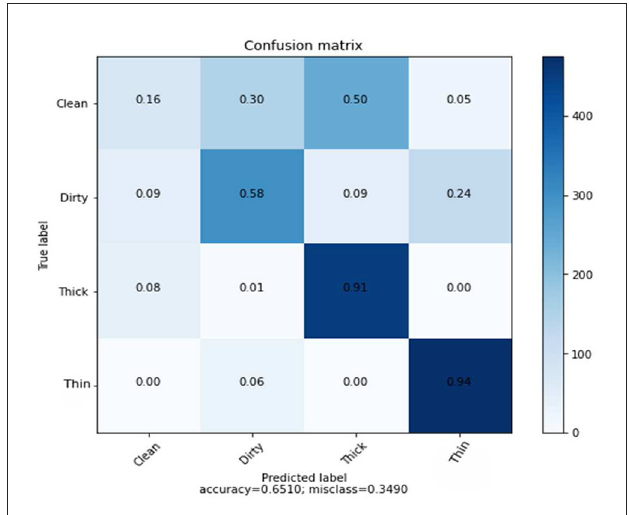
FIGURE6 Confusion matrix of GLCM features using SVM classifier.